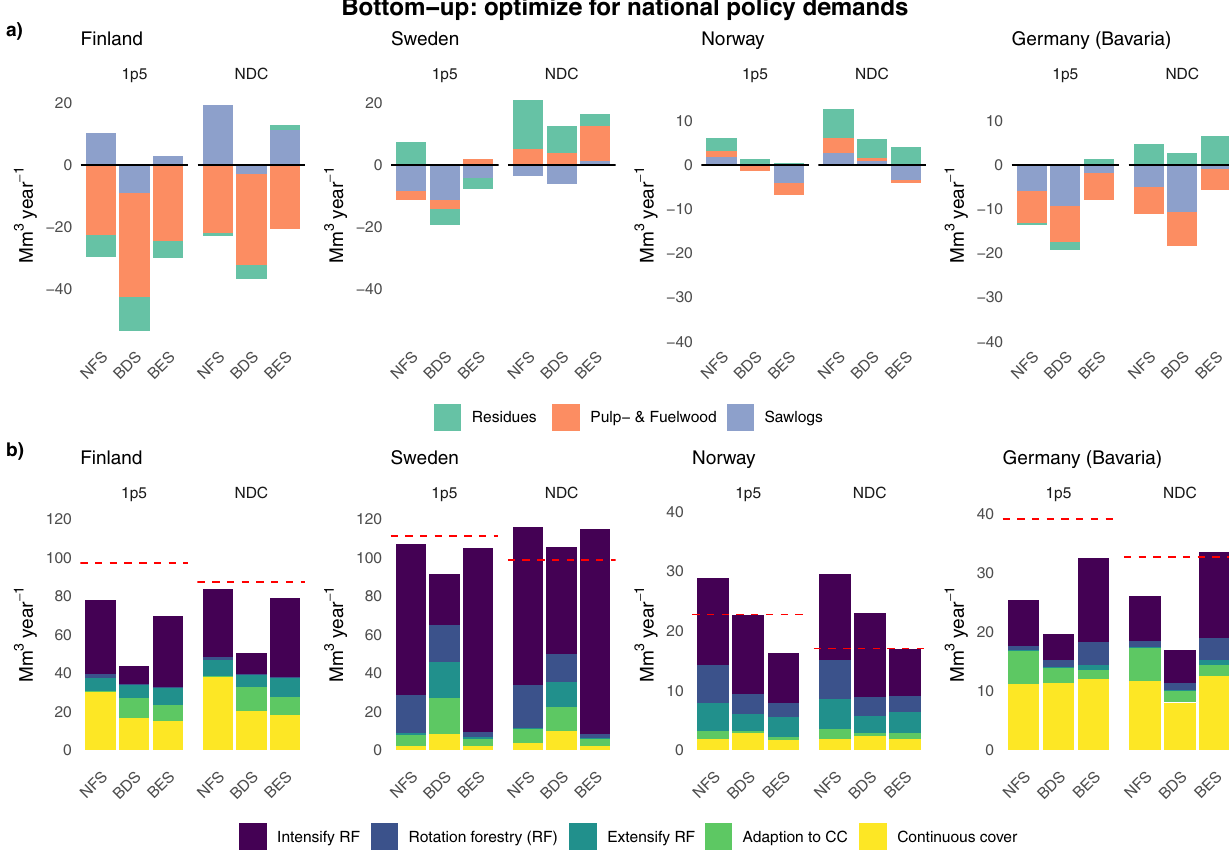
Fig. 3 Bottom-up optimization outcomes for national policy demands of forest ecosystem services and biodiversity. a Difference between harvest demands for EU climate change mitigation targets (1p5 and NDC, see Fig. 2) and forecasted harvests under national policy scenarios by assortments. Bars below the black line indicate that the demand for that assortment is not met (an exceed of sawlogs could be used to alleviate an under-production of pulp- & fuelwood and residues, e.g., Finland). b Forecasted harvests by management classes. The bars in both plots, a and b represent mean values over the planning horizon. The red dashed line in b represents the average harvest demand of each mitigation target, NFS stands for national forest strategy, BDS for biodiversity strategy, BES for bioeconomy strategy. Note variable scaling of y